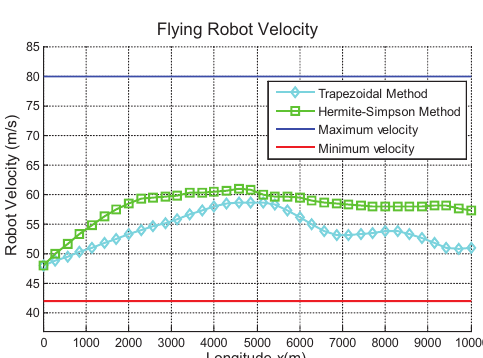
Figure 6. Yaw angle curve